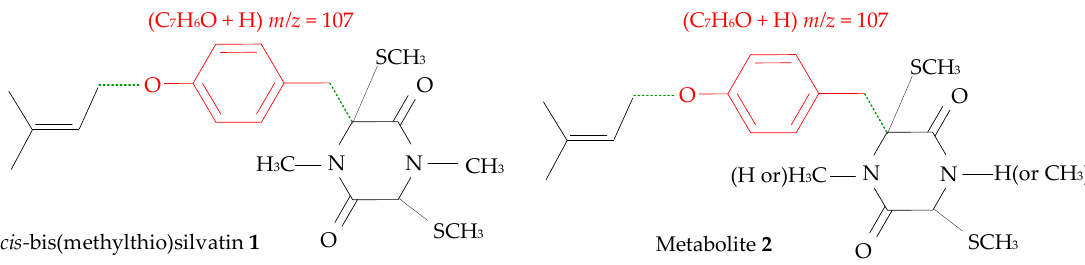
Scheme 1. Substructure colored in red has been assigned to ion C 7 H 7 O + at m / z = 107 in Figure 5, while substructures in black represent the neutral losses for its formation from the parent ion.